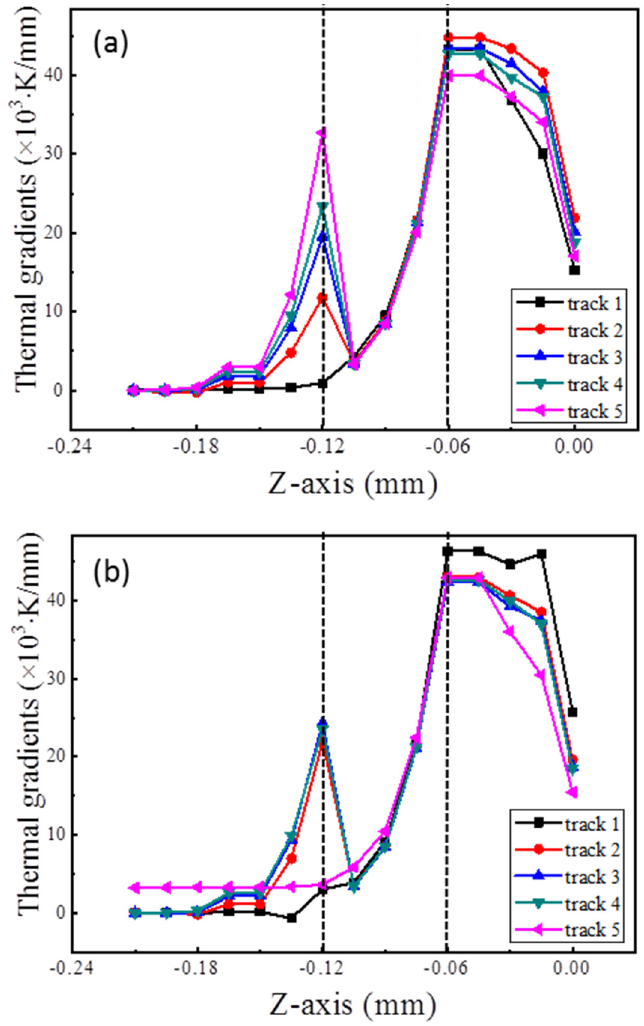
Figure 6. The distribution of thermal gradients in the Z -axis (X = 0.495 mm, Y = 0 mm, 0.12 mm, 0.24 mm, 0.36 mm and 0.48 mm, respectively, from track 1 to track 5 in both simulations). ( a ) Forming from the main body and ( b ) forming from the overhang.